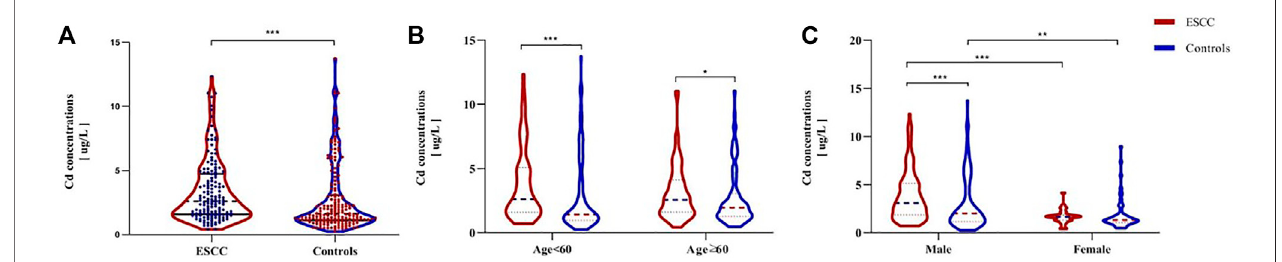
FIGURE1| Comparison ofBCLsbetweenESCC patientsand healthycontrols (A) andBCLs incasesand controlsaccordingtotheir ageand sex (B – C) . p -values were calculated using the Mann – Whitney U test. * p < 0.05; ** p < 0.01; *** p < 0.001, compared with the designated controls.